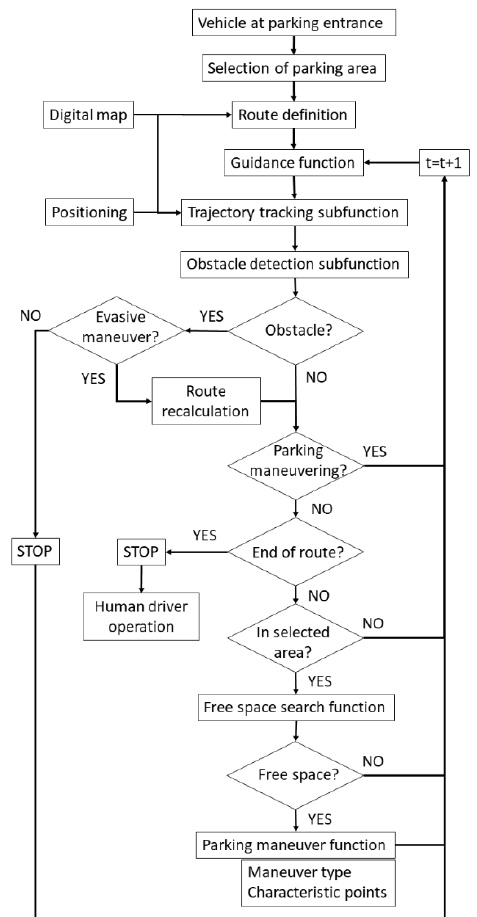
Figure 1. Algorithm of the autonomous valet parking system, including scenario perception, vehicle positioning, guidance function, free space search, and parking maneuver.